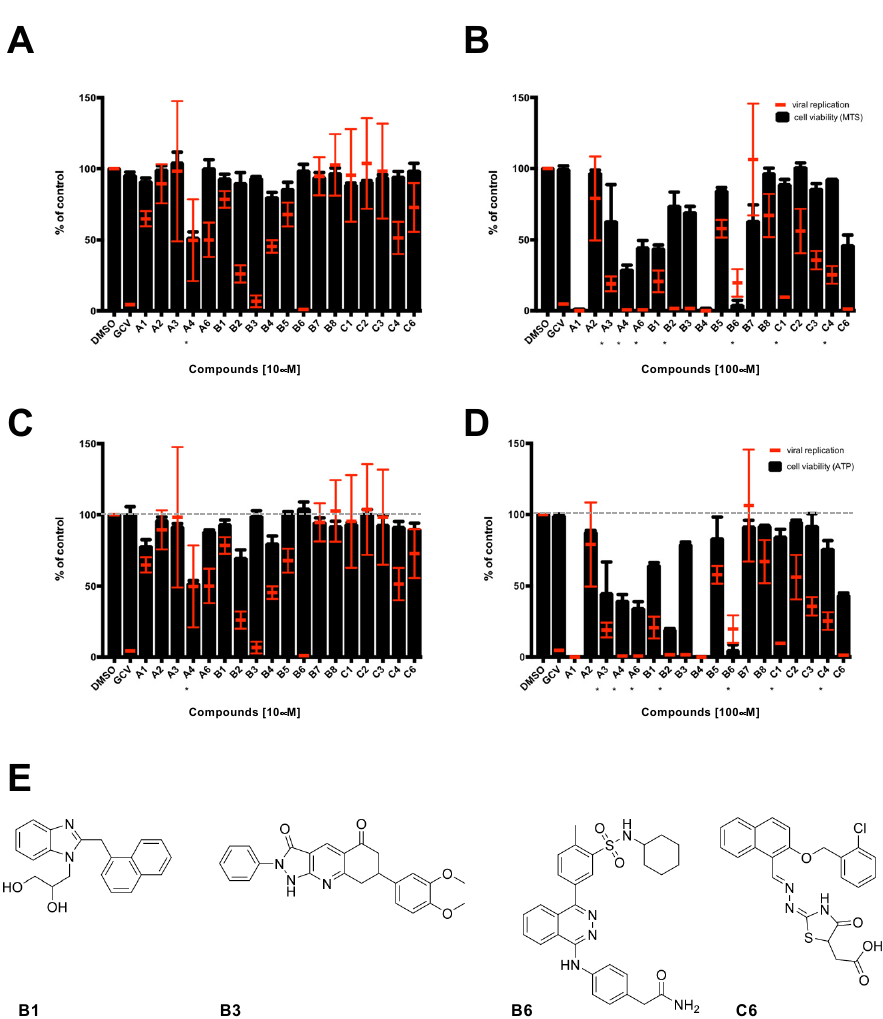
Figure 2. Identification of compounds interfering with HCMV replication. MRC5 cells were infected with TB4-UL83-EYFP at an MOI of 0.03 IU/cell and treated with each SM either at concentration of 10 µ M ( A , C ) or 100 µ M ( B , D ). In parallel, uninfected MRC5 cells were also treated for assessment of SMs cytotoxicity. Seven days post treatment, cells were processed for data acquisition and analysis as described in the Materials and Methods section. Mean YFP values relative to infected cells treated with the indicated SMs are expressed as a percentage of DMSO-treated cells (red bars). Cell viability was assessed by MTS ( A , B ) or Cell Titer Glo ® assays ( C , D ), and data expressed as a percentage of DMSO-treated cells (black columns). The mean + standard error of the mean (SEM) relative to 3 independent experiments is shown. * indicates the presence of precipitates. ( E ) The chemical structure of active molecules is